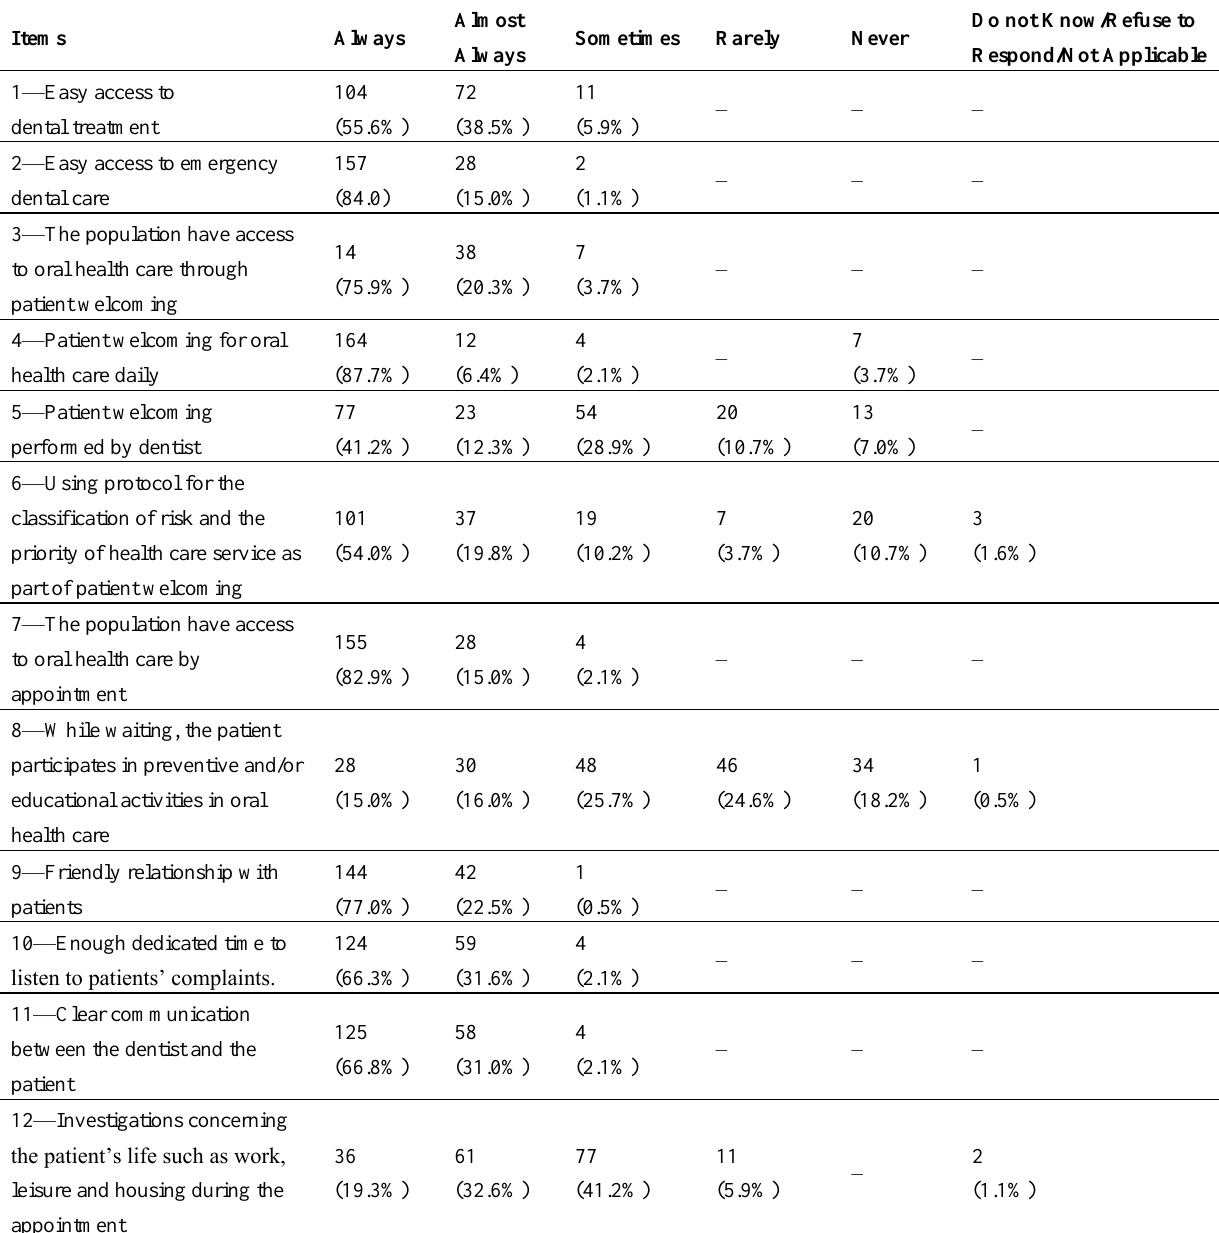
Table 1. Items of the instrument and frequency of